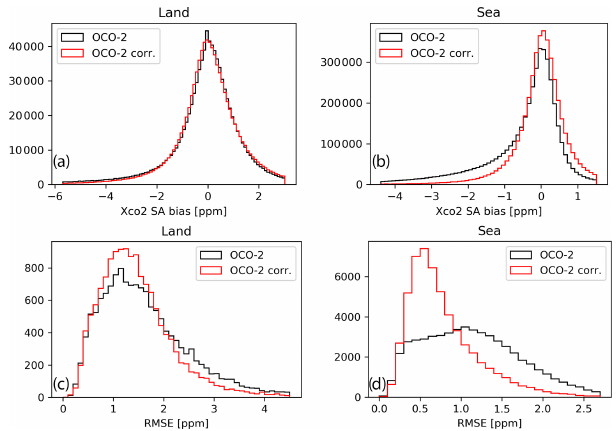
Figure 4. Reduction in non-physical variability in X CO 2 and the proposed bias correction approach (OCO-2 corr.) for land (a, c) and sea (b, d) for QF = 0 and QF = 1 data from 2018 to 2019. (a, b) Distribution of biases from individual soundings, (c, d) distribution of standard deviation for individual small